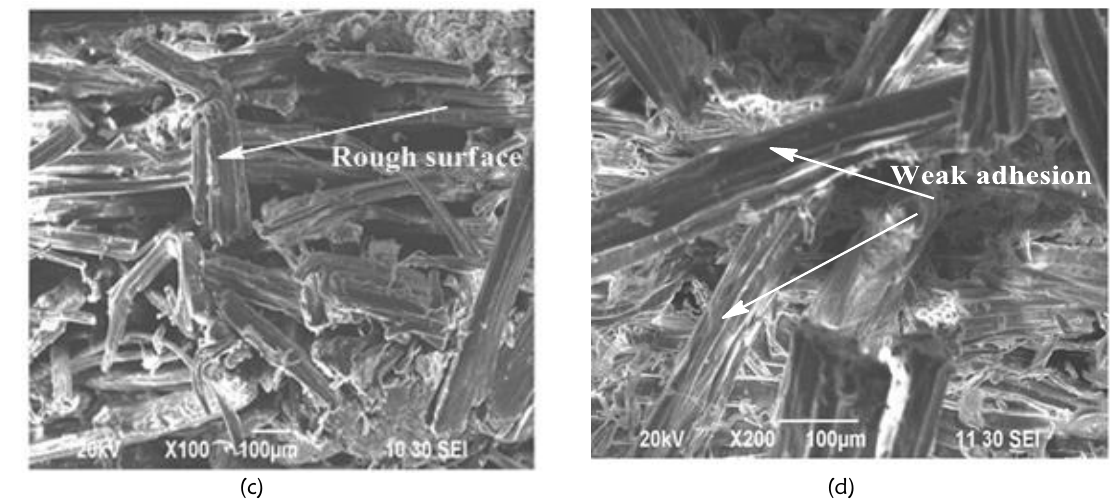
Figure 14: (c), (d) SEM micrographs of treated fiber